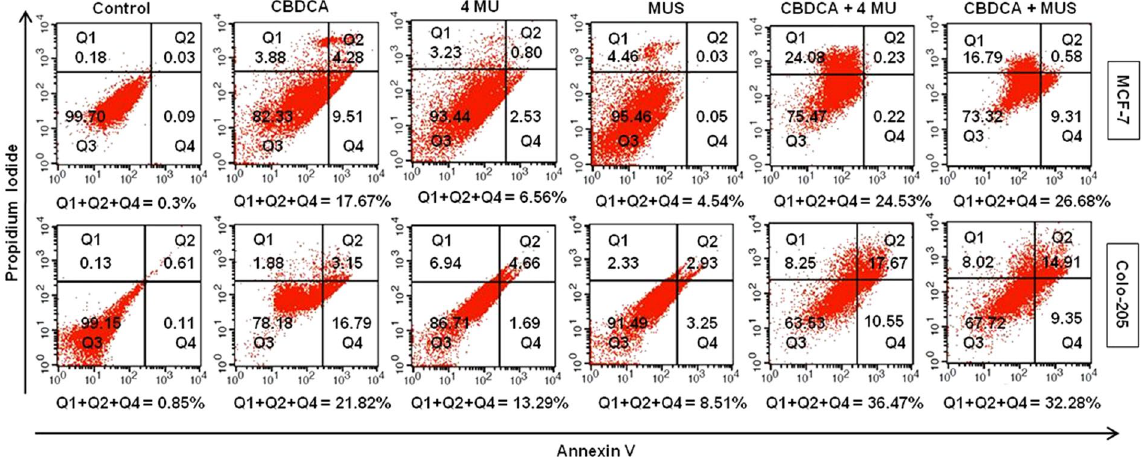
Figure 4. Effect of 4 MU and MUS in combination with CBDCA in MCF-7 and Colo-205 cell lines. After 48 h incubation with CBDCA, 4 MU, and MUS alone or in combination with their corresponding IC 25 , the cells were stained with annexin-V and PI as described in Methods and analyzed by flow cytometry. The figure is a representative profile of at least three experiments in duplicate.